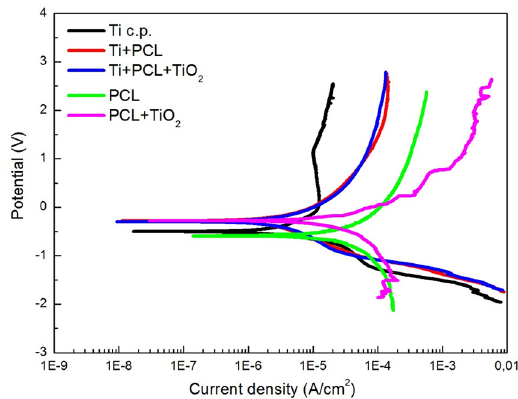
Figure 6. Polarization curves obtained at physiological condition: (black) Ti cp, (red) Ti cp+PCL, (blue) Ti cp+PCL+TiO PCL film, and (pink) PCL+TiO